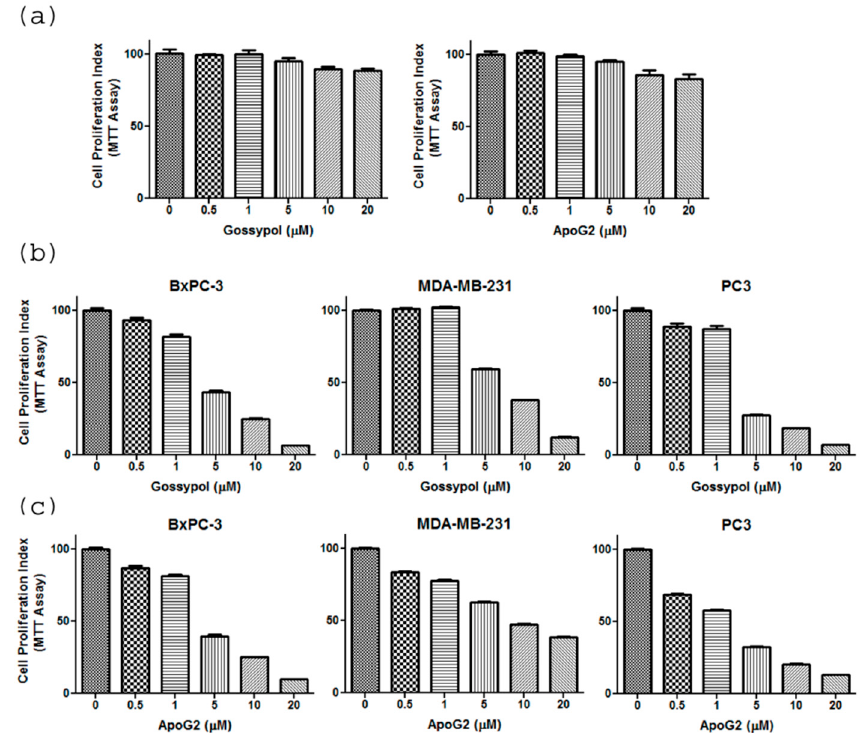
Figure 1. ( a ) The cell proliferation of normal breast epithelial cells (MCF10A) in presence of gossypol and ApoG2 was detected using MTT (3-(4,5-dimethylthiazol-2-yl)-2,5-diphenyltetrazolium bromide) assay. MCF10A cell were incubated with increasing concentration of gossypol/ApoG2, as indicated, for 72 h. Similarly, the cell proliferation of pancreatic cancer cell line, BxPC3; breast cancer cell line, MDA-MB-231; and prostate cancer cell line, PC3; in presence of increasing concentrations of ( b ) gossypol and ( c ) apogossypolone, as indicated, was detected using MTT assay. The cells were incubated for 72 h. MTT assay was performed as described in the Materials and Methods. All results are present as percentage of control (±SEM) of three independent experiments.